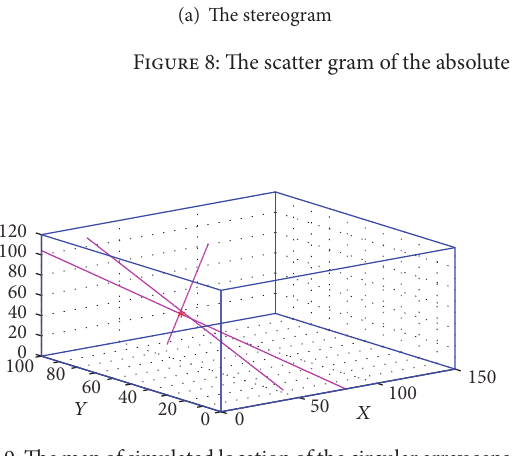
Figure 9: The map of simulated location of the circular array sensor. “ ∗ ” refers to the position of the PD